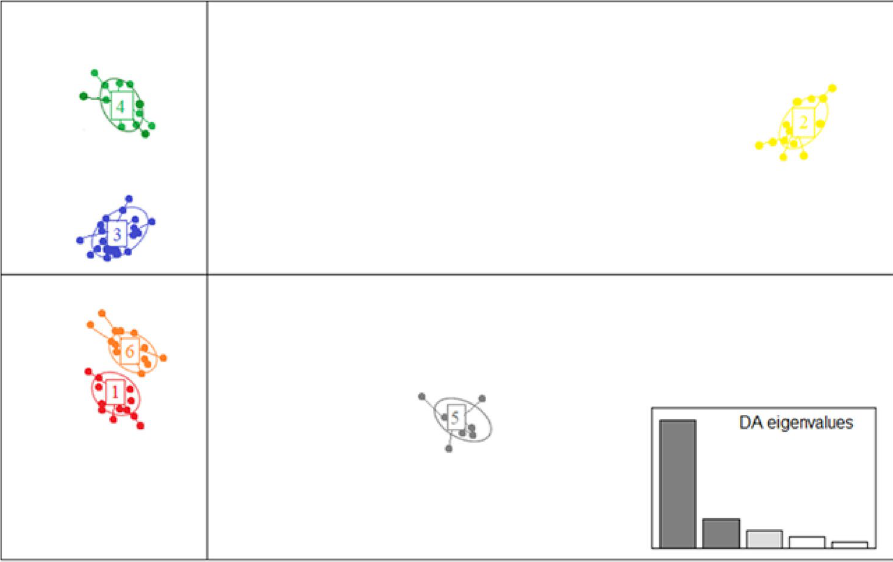
Figure 1. Discriminant analysis of principal components (DAPC) for 127 accessions of Triticum turgidum L. used for the analysis. The axes represent the first two Linear Discriminants (LD). Each circle represents a cluster and each dot represents an individual. Numbers represent the different subpopulations identified by DAPC